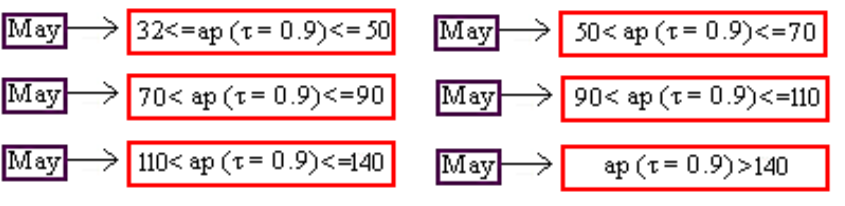
Fig. 7. Example of scheme followed to select data relative to 6 different disturbed geomagnetic conditions for a given month